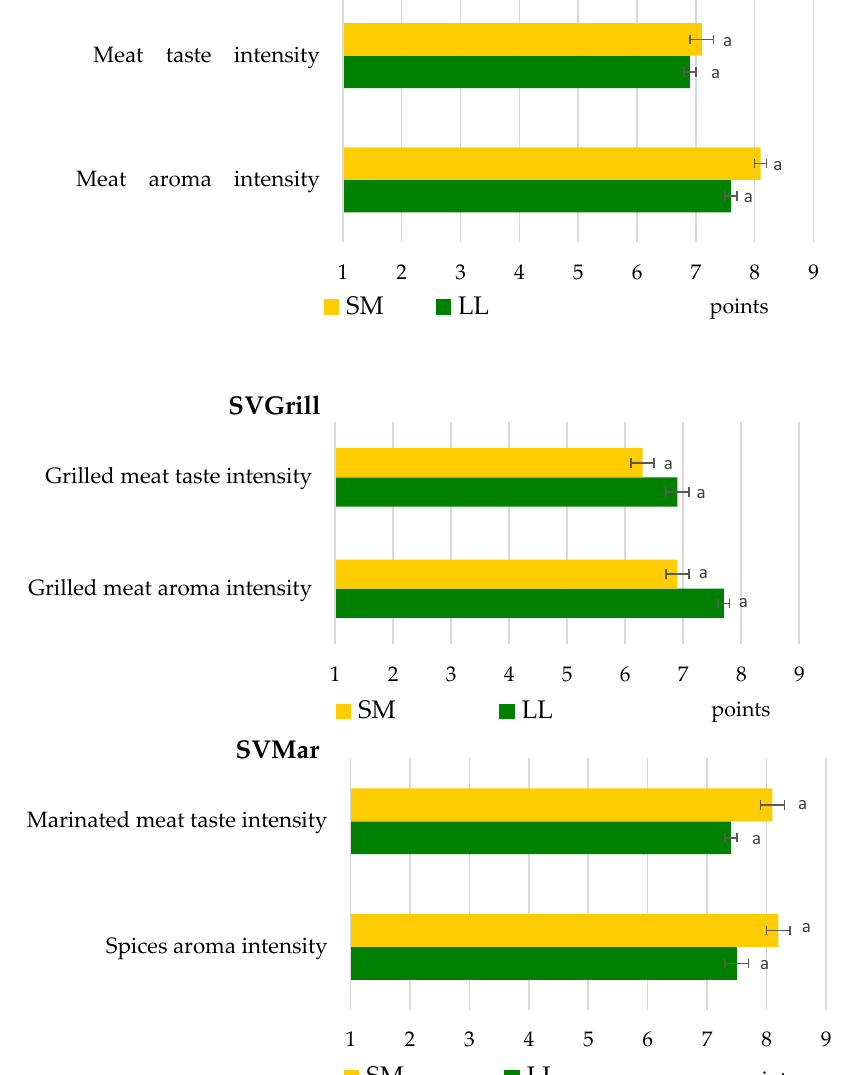
Figure 4. Cluster analysis of semimembranosus (SM) and longissimus lumborum (LL) muscles subjected to sous vide (SV), sous vide and grilling (SVGrill), and marinating and sous vide (SVMar).